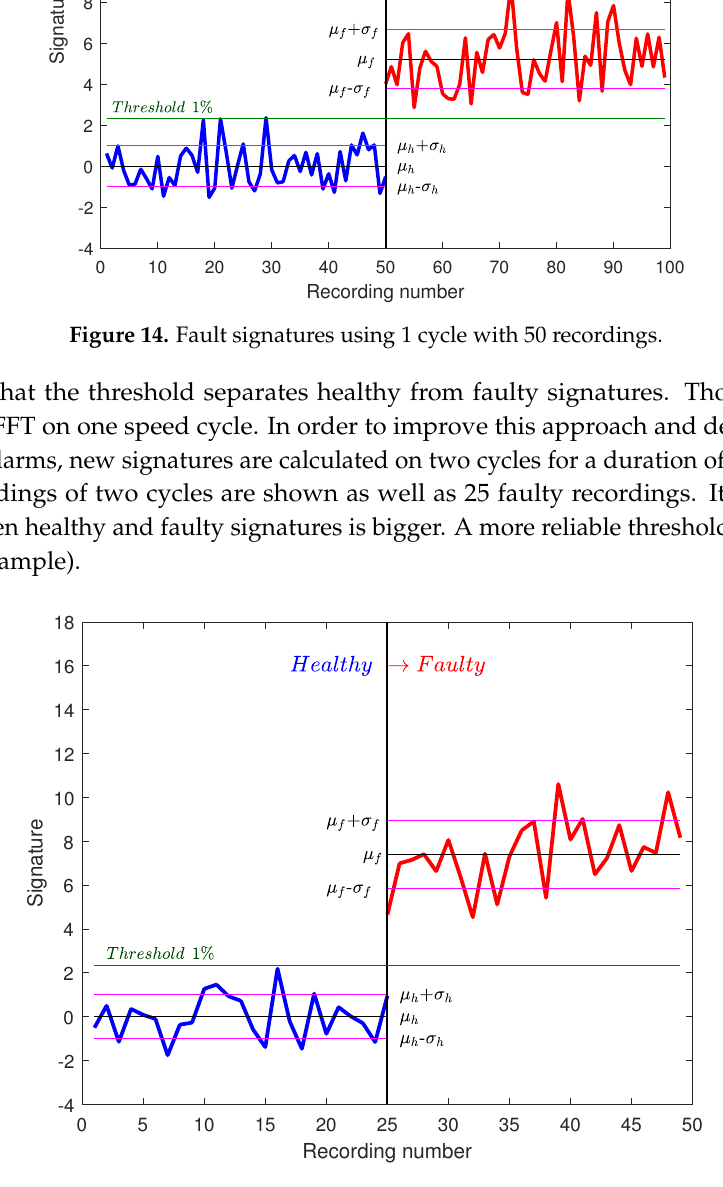
Figure 15. Fault signatures using 2 cycles with 25